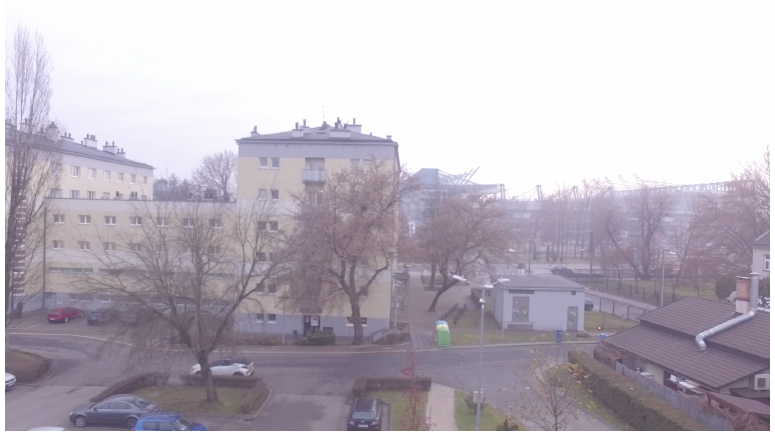
Figure 2. The view from the flying weather